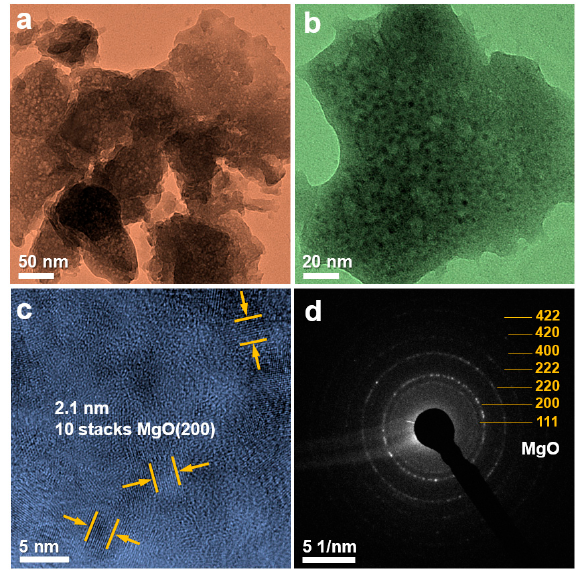
Figure 6. ( a – c ) Transmission electron microscope (TEM) images of MgO nanoplates; ( d ) selected area electron diffraction (SAED) pattern of a nanoplate.